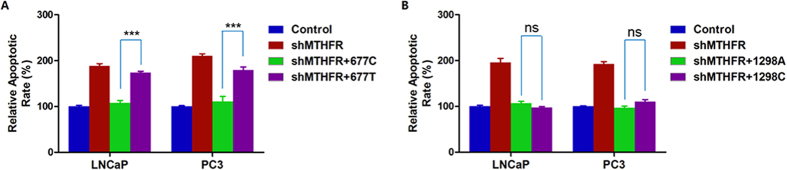
MTHFR c.677T variant increases cell apoptosis.(A) c.677T variant of MTHFR increases cell apoptosis remarkably in both LNCaP and PC3 cell lines. (B) c.1298C variant of MTHFR has no effect on cell apoptosis. ***Indicates P < 0.001, ns indicates no significance.